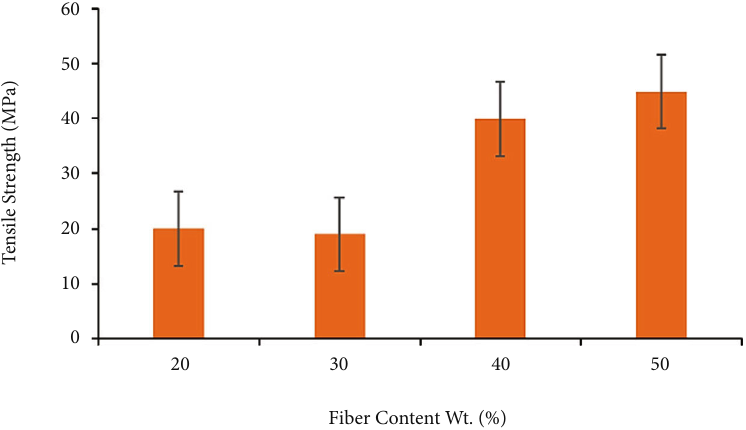
Figure 4: Tensile strength vs. fi ber